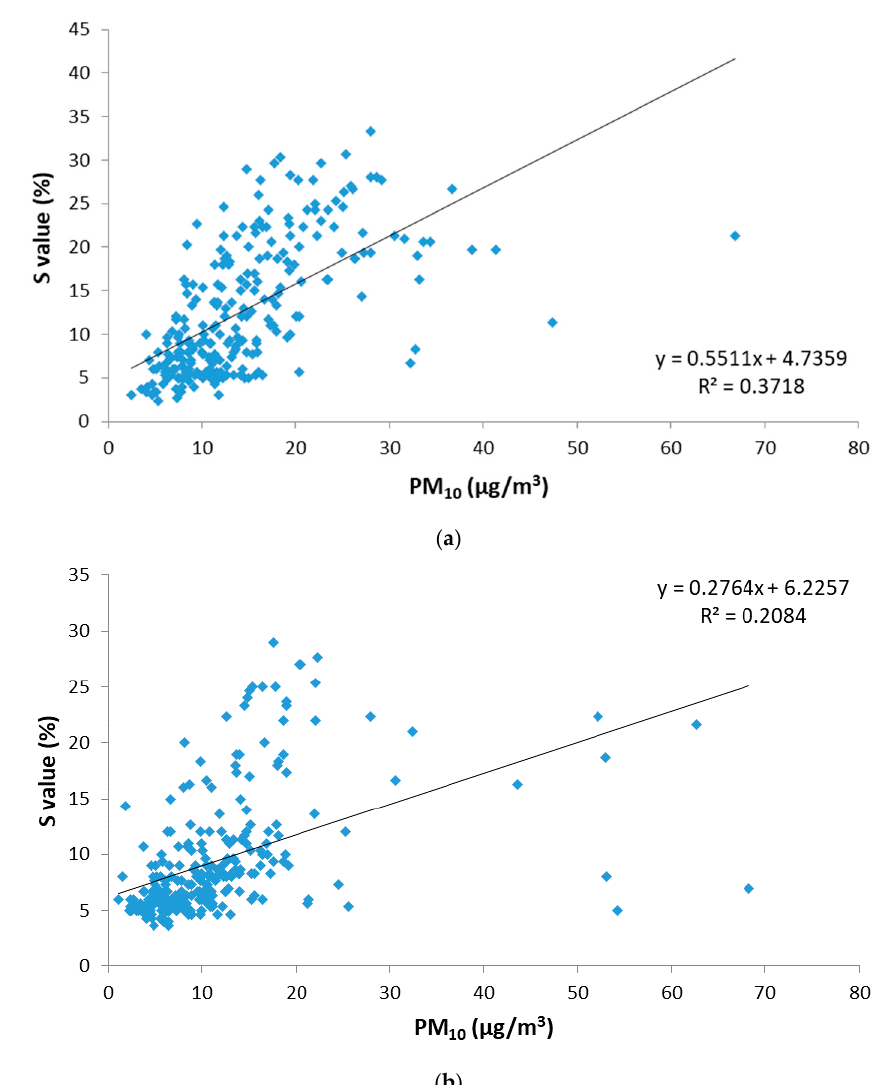
Figure 9. Relationship between saturation (S HSV ) and gravimetric PM 10 concentration for days under local source influence (No-SDO days) during 2015. ( a ) At Badajoz location; ( b ) at Monfragüe location.